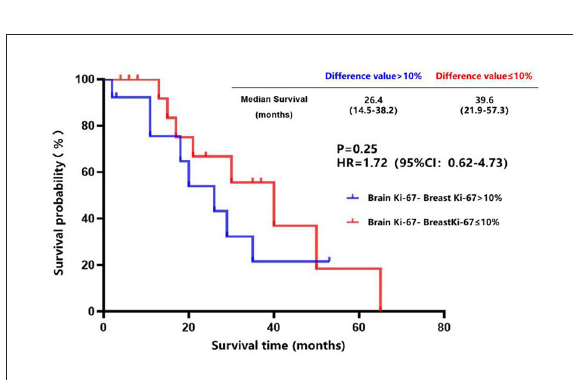
FIGURE8 Survival curves of patients whose Ki-67 index difference of > 10% vs. patients whose Ki-67 index difference of ≤ 10% after diagnosis of brain